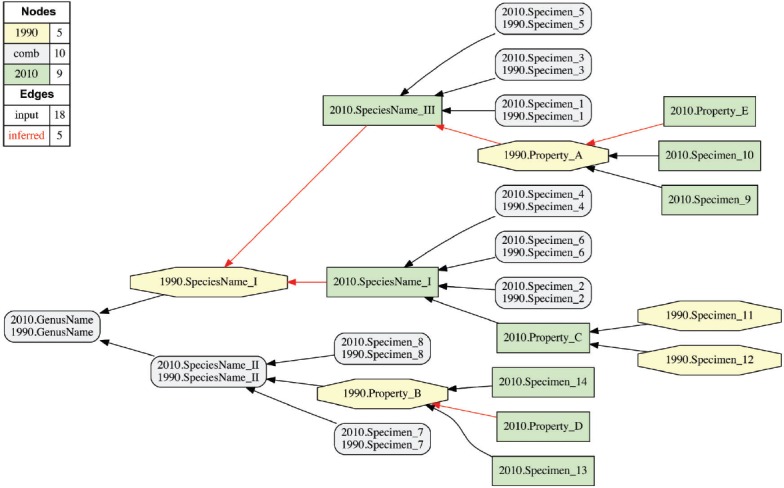
Hypothetical alignment (1/2 possible worlds shown) whose input entails two incongruent sets of taxonomic concepts, character concepts, and specimen-to-taxonomic concept or specimen-to-character concept assignments. The earlier (1990) and later (2010) treatments involve overlapping sets of specimens, where Specimens 1–8 are shared (i.e., re-/examined in each treatment), Specimens 9–10 and 13–14 are only included in the 2010 treatment, and Specimens 11–12 are exclusively observed in the 1990 treatment. The five species-level taxonomic concepts respectively include 2–5 Specimens and one Property (A–E). Specimens are either directly assigned to parent concepts (as their is_a children), or are identified to properties (which are represented as concepts in themselves) via (>, <) articulations. Only two concept-to-concept articulations are provided: (i) 2010.SpeciesName_II 1990.SpeciesName_II and (ii) 2010.GenusName == 1990.GenusName. The reasoning process yields an alignment with unambiguous articulations among higher-level concepts and their==properties that are logically grounded in the specimen-level articulations.